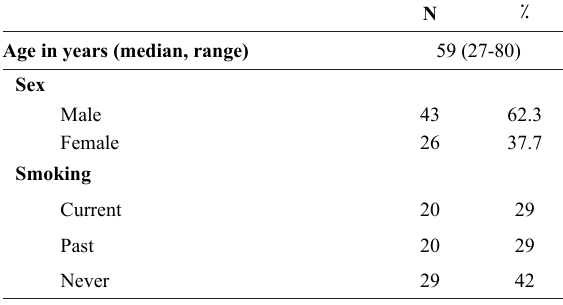
Figure 3: The relation between MPV/PC ratio and age of patients with advanced NSCLC. Table 1: Patients’ characteristics